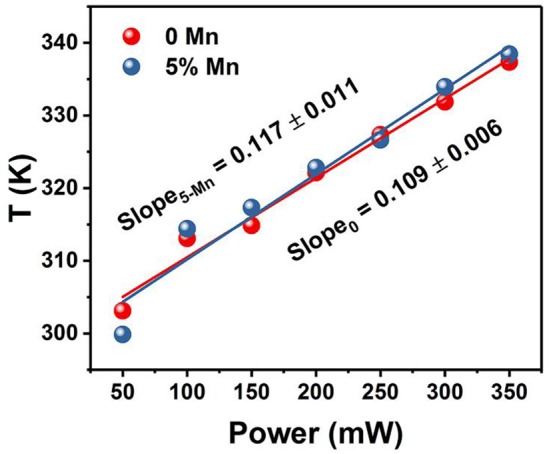
Temperature variation of xMn2+, Er3+, Yb3+ codoped NaGdF4 (x = 0, 5 mol%) powder as a function of pump power density.